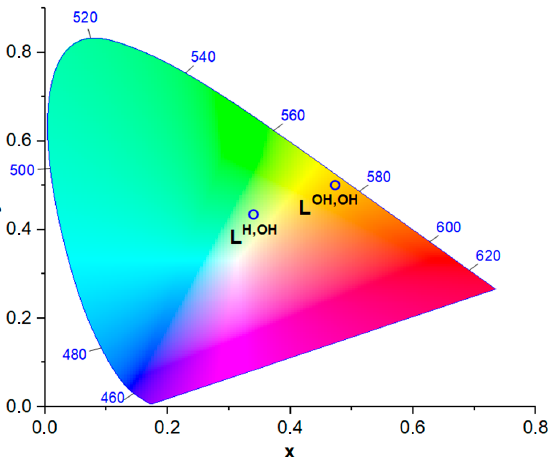
Figure 7. CIE 1931 diagram showing the chromaticity of the emission of L H,OH and L OH,OH in the solid state at λ ex = 320 nm.